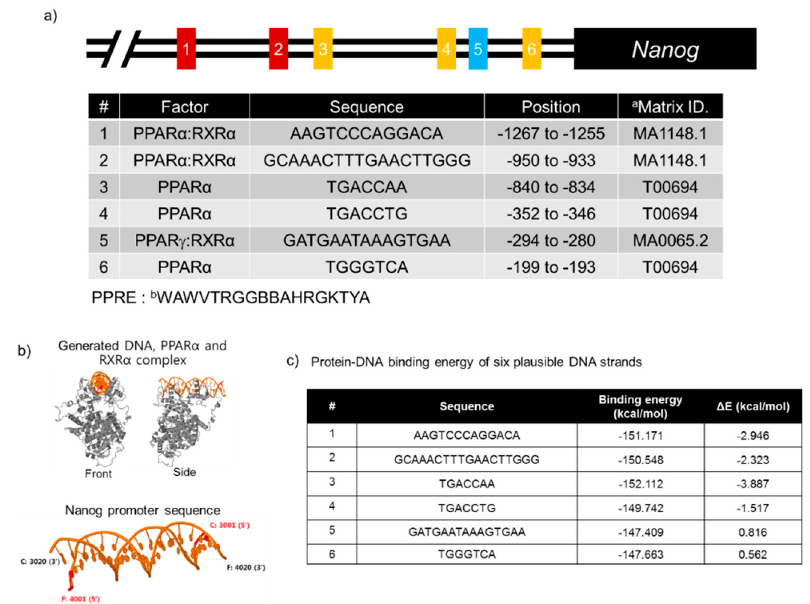
Figure 3. Predictive peroxisome proliferator response elements (PPREs) in the Nanog promoter region. ( a ) Putative PPAR α /RXR α , PPAR α , or PPAR/RXR α binding sites within − 1.5 kb of the transcription start site of the Nanog promoter were identified by using JASPAR and PROMO (version 8.3 of TRANSFAC). a. MA1148.1 and MA0065.2 are the matrix IDs for JASPAR, and T00694 is the matrix ID for PROMO. b. W: A or T, V: A or G or C, R: A or G, B: C or G or T, K: G or T, and Y: C or T. ( b ) Structure construction of the mouse PPAR α /RXRa and Nanog DNA complexes, which are drawn by gray and yellow cartoons, respectively. ( c ) Calculation of protein-DNA binding energy. The protein-DNA binding energies of six plausible DNA strands are numbered from 1 and 6 in the first column. The ‘Seq’ column represents the corresponding sequences with the predicted or revealed DNA sequences as shown ( a ). ‘Binding energy’ indicates the protein-DNA binding energy in units of kcal/mol. ‘ ∆ E’ is the relative binding energy with respect to the reference energy, which is the average energy of all binding energies on the whole sequence.